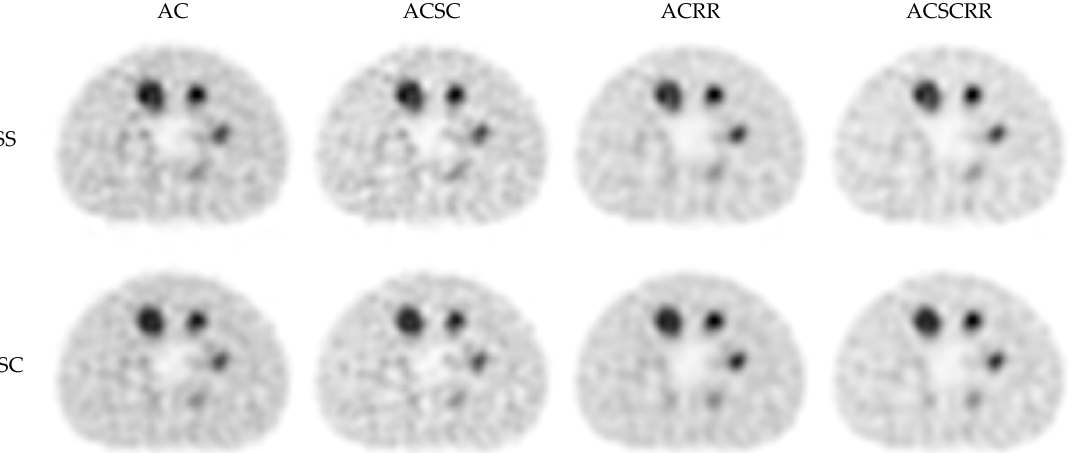
Figure 4. Relationship between %CV and correction methods among scan modes.